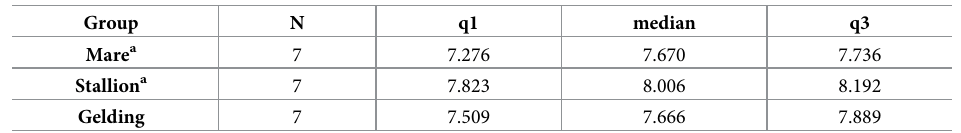
Table 2. pH values in the prosternum